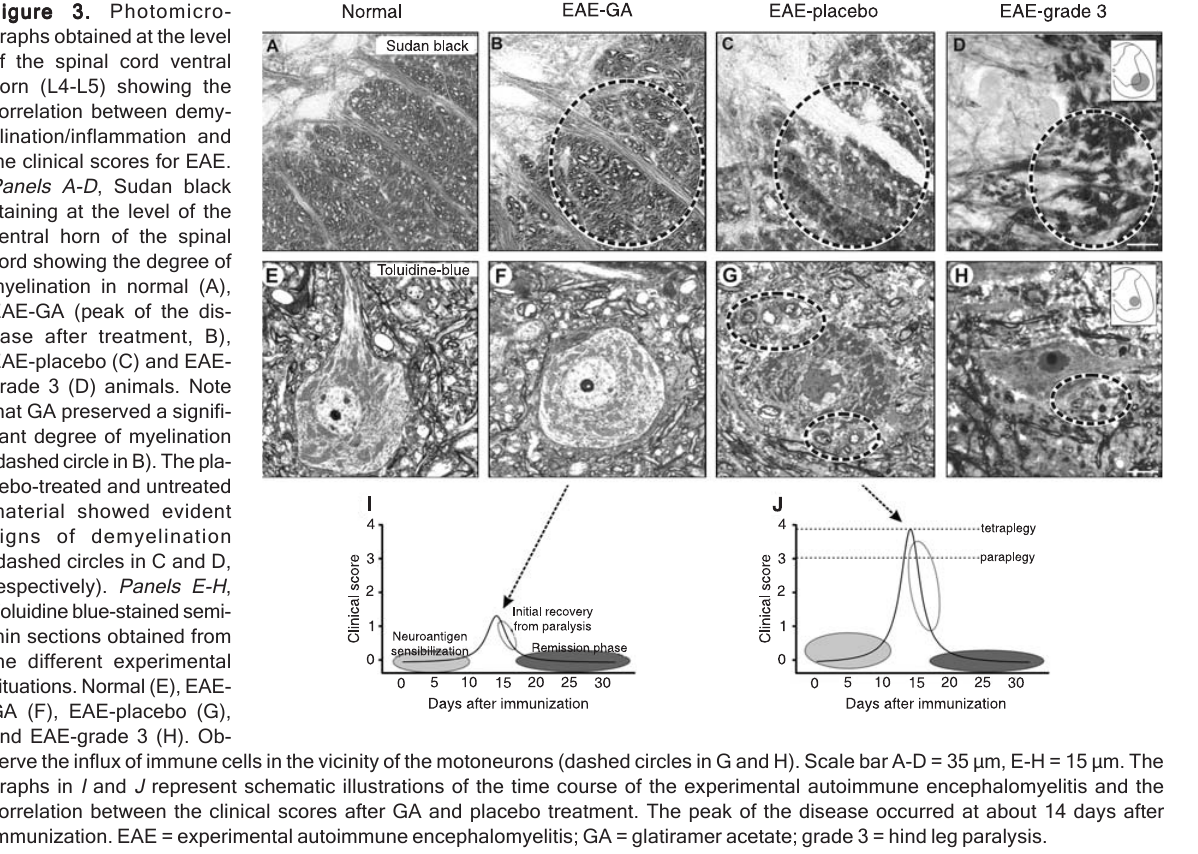
correlation between the clinical scores after GA and placebo treatment. The peak of the disease occurred at about 14 days after immunization. EAE = experimental autoimmune encephalomyelitis; GA = glatiramer acetate; grade 3 = hind leg